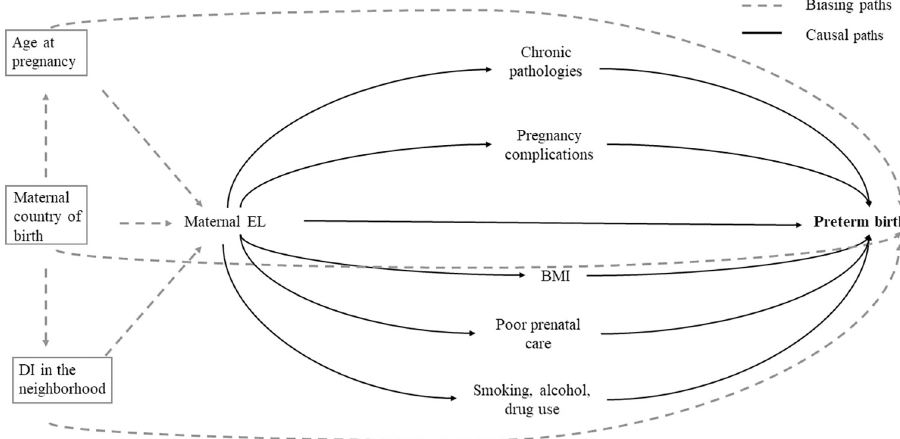
Fig 1. Direct Acyclic Graph (DAG) of the association between maternal educational level and preterm birth including confounder and intermediate variables DI: Deprivation Index; EL: Educational Level; BMI: Body Mass Index. The DAG shows some possible causal pathways between educational level and preterm birth. Age at pregnancy, maternal region of birth and DI of the neighbourhood generate biasing pathways since all three variables are associated with both the exposure and the outcome but they are not in the causal pathway. Adjusting for these variables (represented by framing them) block the biasing pathways and maintain the causal pathways of interest.